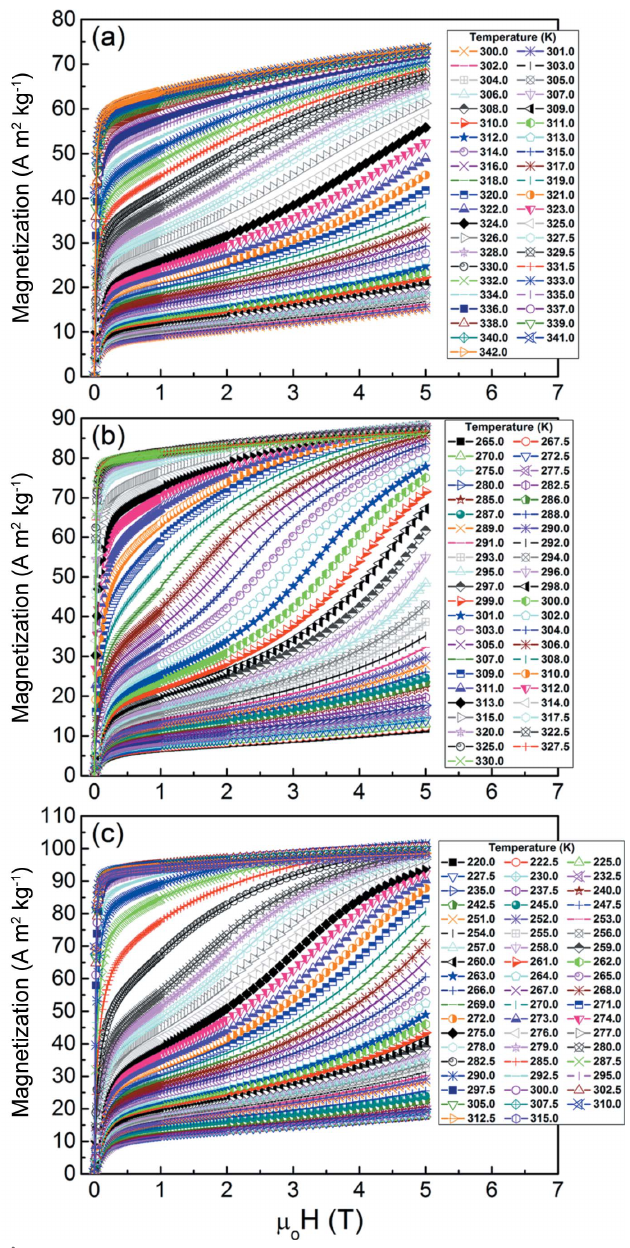
Figure 8 Isothermal magnetization curves across the magnetostructural (marten- site to austenite) transformation with a maximum applied magnetic field of (cid:2) 0 H max = 5 T for ( a ) Mn 50 Ni 36 Co 6 Sn 8 , ( b ) Mn 50 Ni 35 Co 7 Sn 8 and ( c ) Mn 50 Ni 34 Co 8 Sn 8 ribbons.